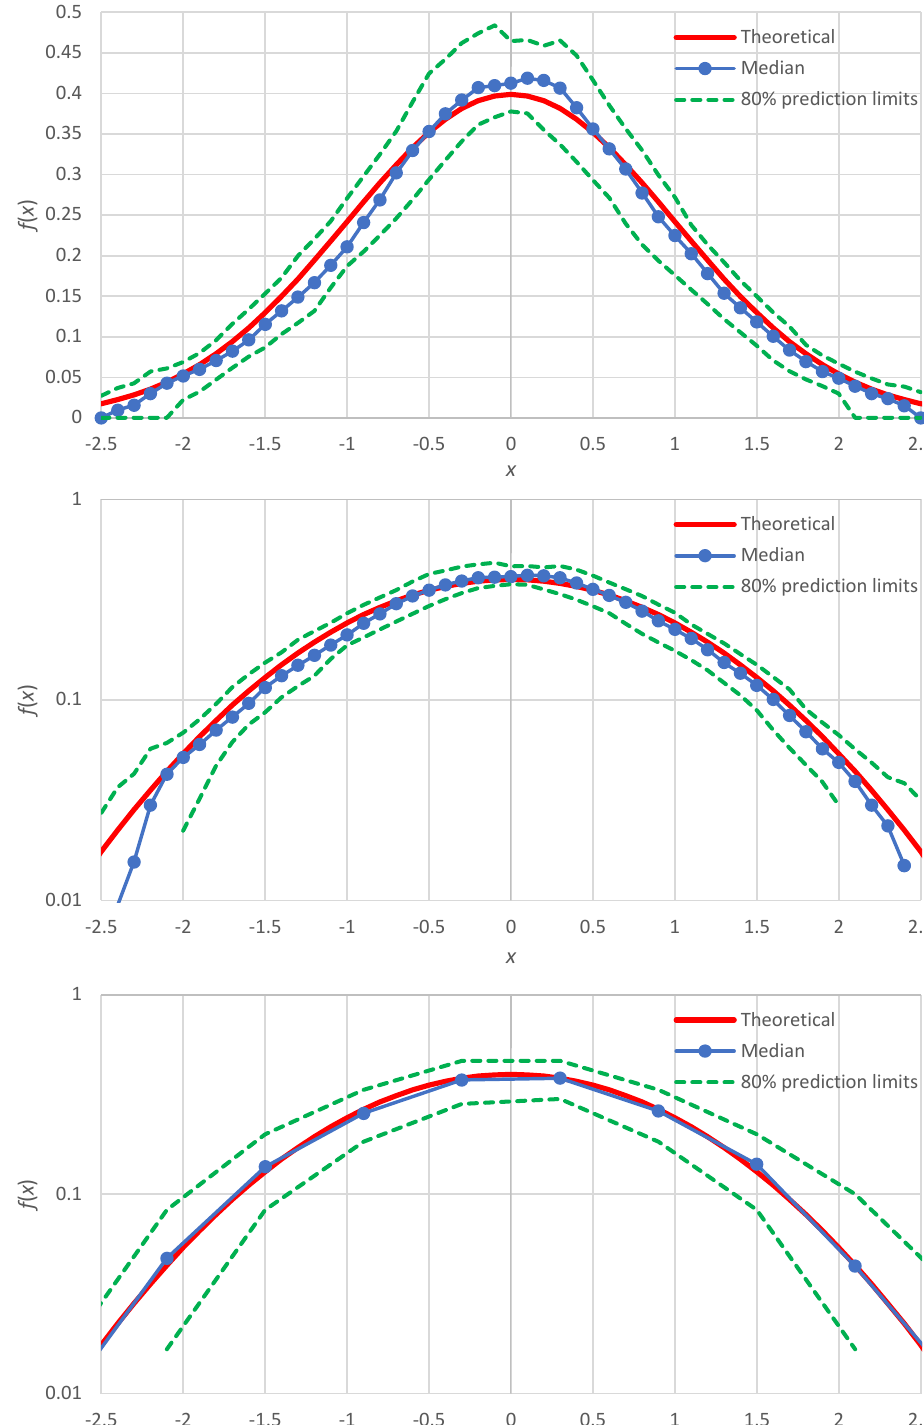
Figure 3. Illustration of the median estimate and uncertainty (in terms of prediction limits) of the probability density as in Figure 2 but for the normal distribution with parameters as in Table 4.